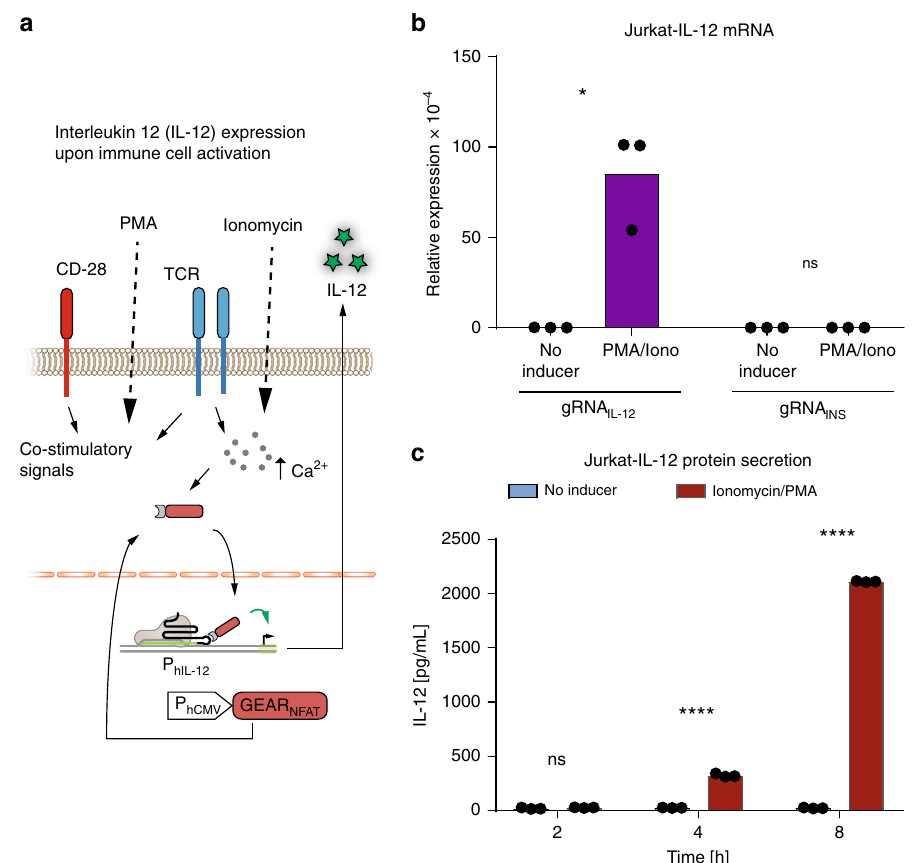
Fig. 4 Interleukin 12 expression upon T-cell activation. a Schematic representation of T-cell activation. T-cell receptor (TCR) signaling is transduced via calcium. An increase in the intracellular calcium level activates GEAR NFAT and leads to elevated expression of interleukin 12 (IL-12). b, c Jurkat cells stably expressing dCas9, GEAR NFAT , and a human IL-12B promoter-speci fi c sgRNA, or an insulin promoter-speci fi c sgRNA as the negative control, were activated with 2 µ g/mL ionomycin and 20 ng/mL PMA. b IL-12B mRNA was quanti fi ed after 8 h. c IL-12B protein was quanti fi ed from the cell culture supernatant after 2, 4, and 8 h. Black dots correspond to individual data points of n = 3 biological replicates. ns nonsigni fi cant, ** p < 0.01, **** p < 0.0001. Statistical signi fi cance was calculated using a two-tailed t -test. A detailed description of the statistical analysis is provided in Supplementary Table 5. Source data are provided as a Source Data fi